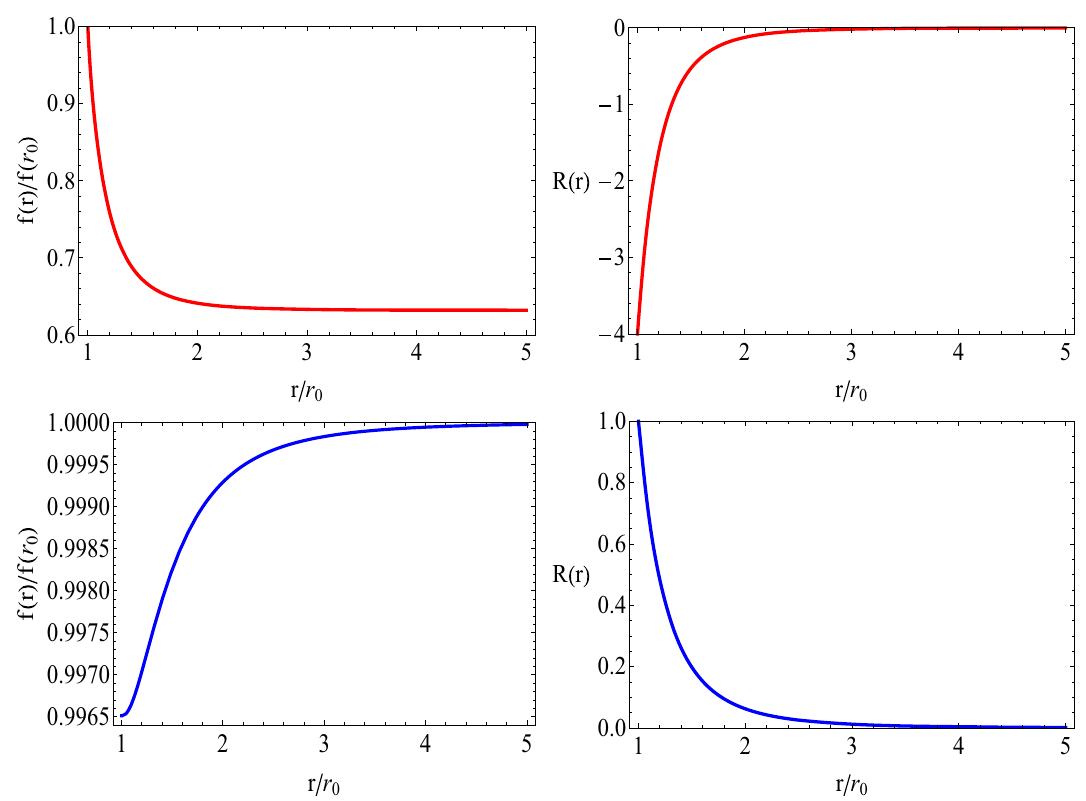
/ 2, r = 1, F = − 1 and f = 20 (blue curves). It is worth β = − r 0 0 0 0 mentioning that from now on throughout the analysis the numerical value assigned to the throat of the WH will be r 0 =